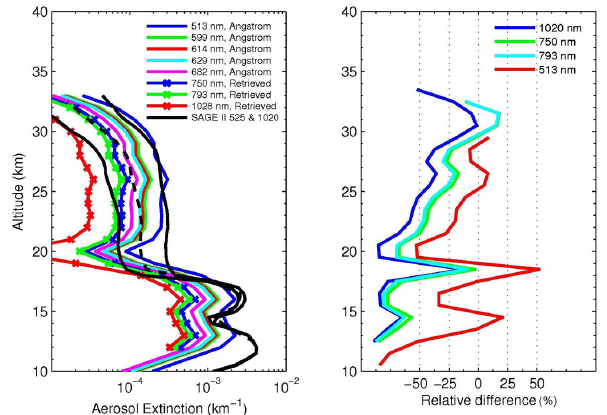
Fig. 11. Same as Fig.10 but for 27 September 2004, latitude 13.2 ◦ N and longitude 32.6 ◦